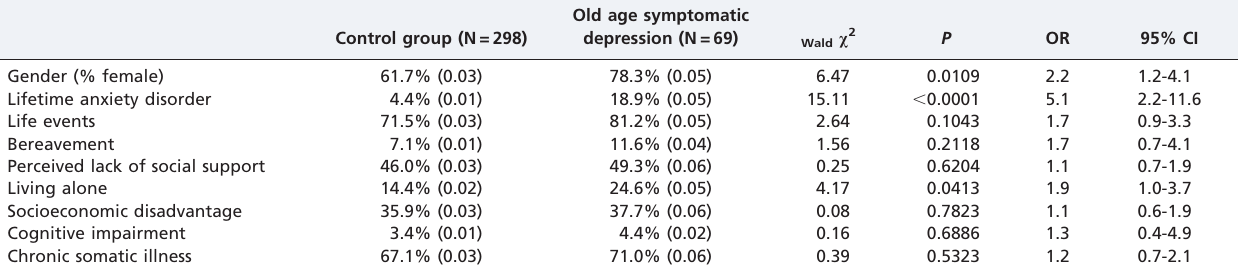
Table 1 - Association among determinants and ‘‘old age symptomatic depression’’: percent (SE) and univariate odds- ratios (95% CI). The Sa˜o Paulo Epidemiologic Catchment Area Study; N of subjects 60 years or older= 367.